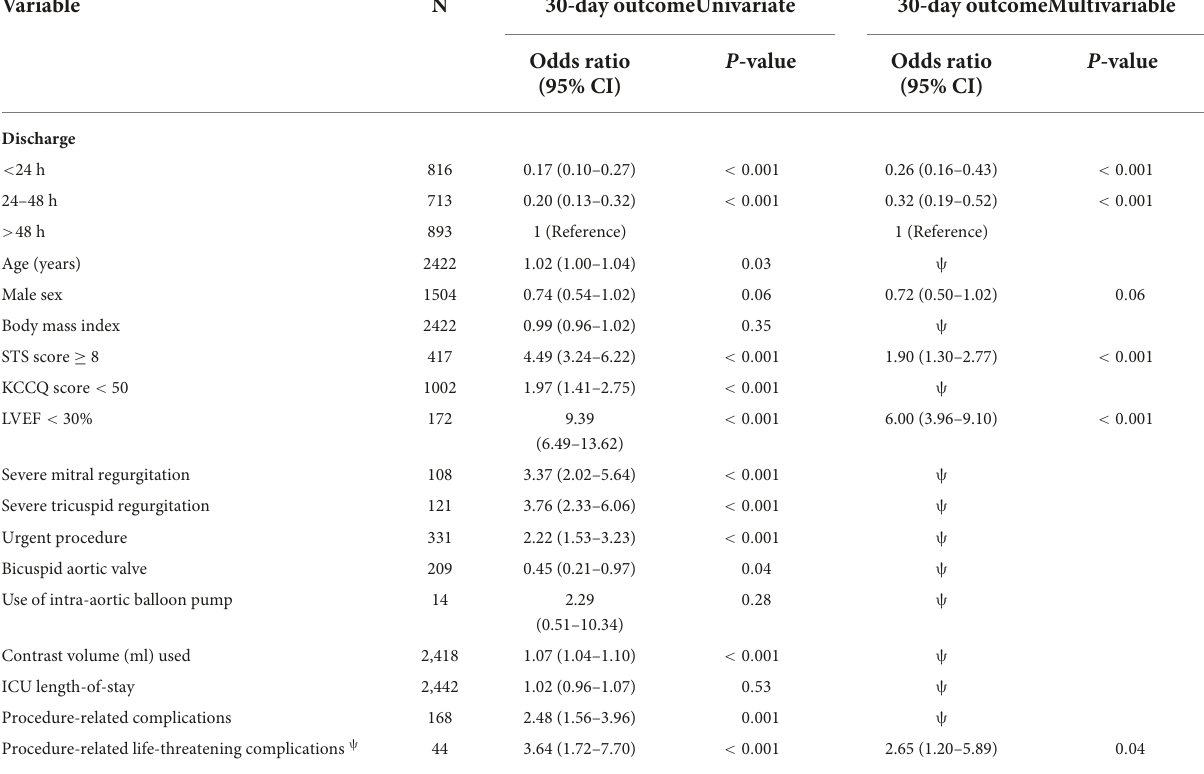
TABLE 5 Univariate and multivariable analyses of 30-day outcome. Variable N 30-day outcomeUnivariate 30-day outcomeMultivariable